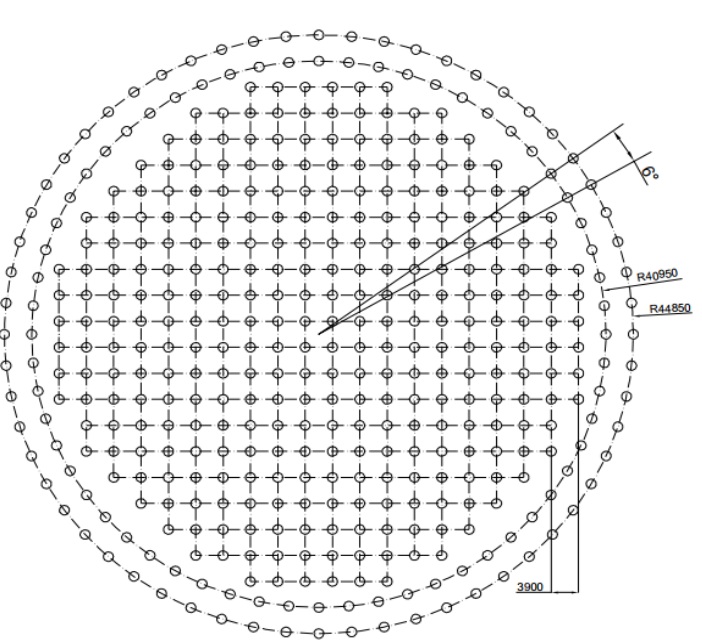
Figure 11. The cross-sectional schematic diagram of the large LNG storage tank (units: mm).